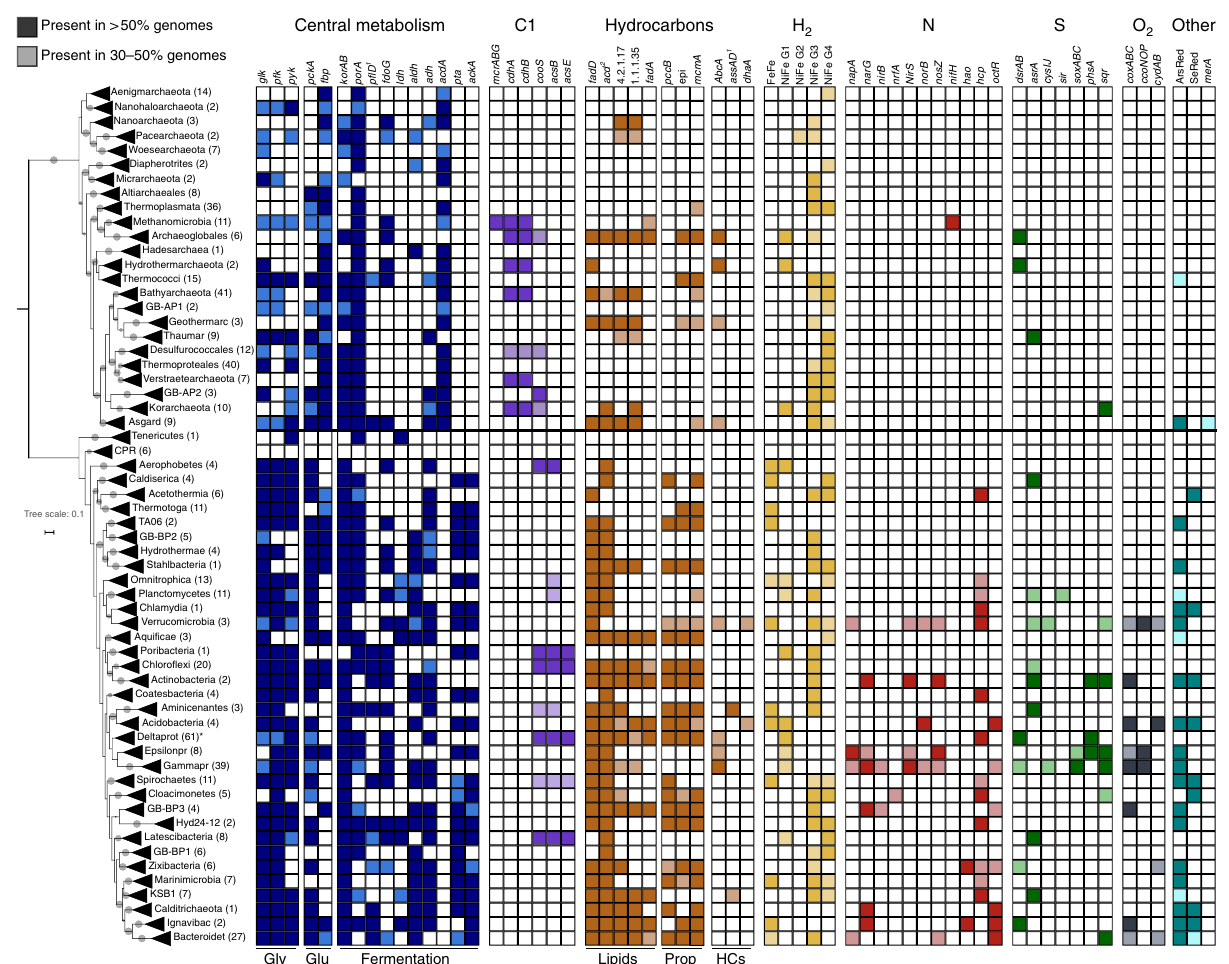
Fig. 4 Core metabolic genes detected across phylogenetic clusters inhabiting GB sediments. Presence of core metabolic genes involved in carbon metabolism, hydrocarbon (HC) degradation and respiration. Shaded colors: Gene present in 30 – 50% of genomes/phylogenetic cluster. Solid colors: Gene present in 50 – 100% of genomes/cluster. C1 C1- compound metabolism, H2 hydrogen metabolism, N nitrogen metabolism, S sulfur metabolism, O 2 oxygen metabolism, ArsRed arsenate reductase, SeRed selenate reductase, Gly glycolysis, Glu gluconeogenesis, Prop propane. Number in brackets: number of genomes belonging to individual phylogenetic clusters. Grey circle: Bootstrap support > 70%. Asterisk: Deltaproteobacteria includes genomes from both Deltaproteobacteria and Thermodesulfobacteria. 1 p fl D and assA are often dif fi cult to discriminate from other glycyl radical enzymes, therefore, an additional phylogenetic analysis can be found in Supplementary Figure 8. 2 Phylogenetical analyses of substrate speci fi city of acd genes can be found in Supplementary Figure 7. A complete list of metabolic genes can be found in Supplementary Data